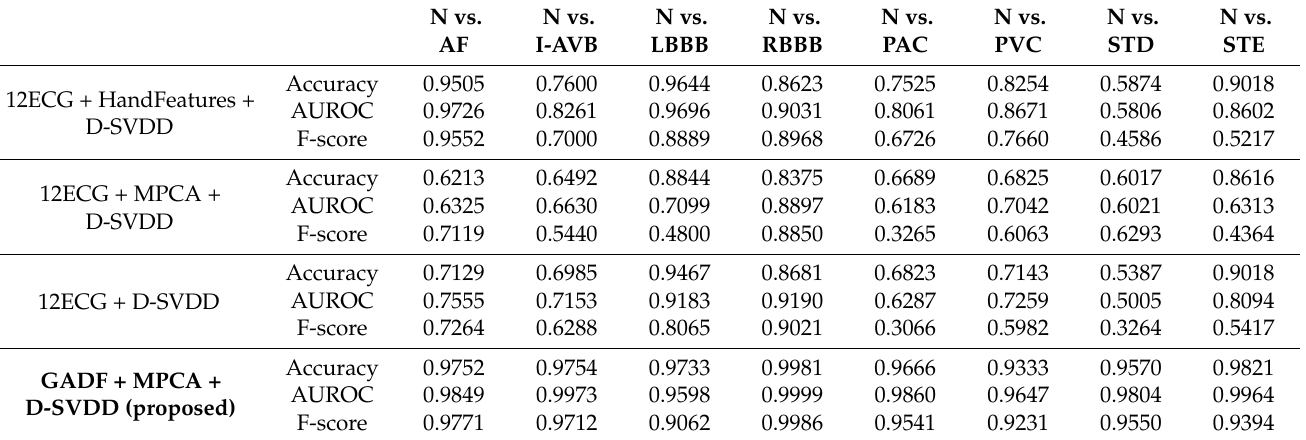
Table 2. Performance Comparison with Benchmark Approaches in Category 1.